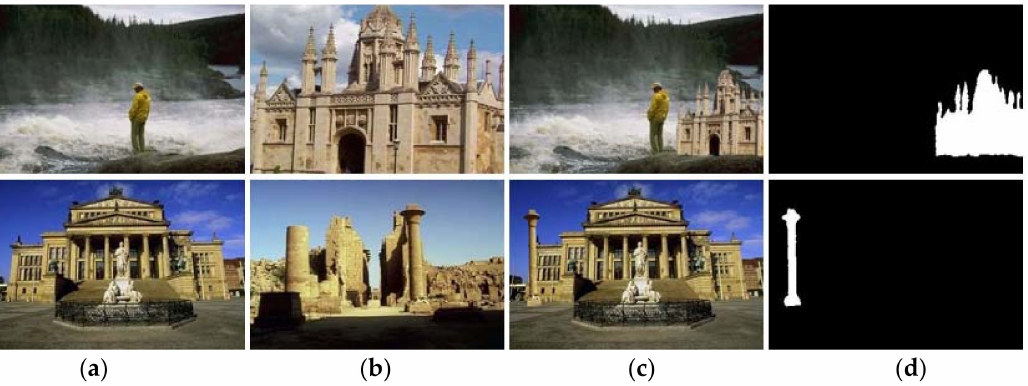
Figure 3. Examples of images in CASIA1.0: ( a , b ) real images, ( c ) tampered images and ( d ) label